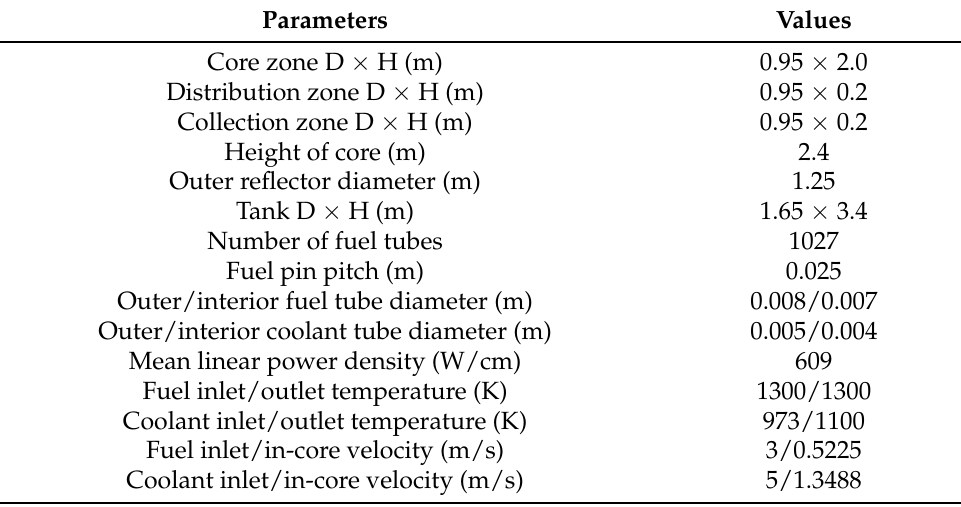
Table 1. SMDFR design parameters.